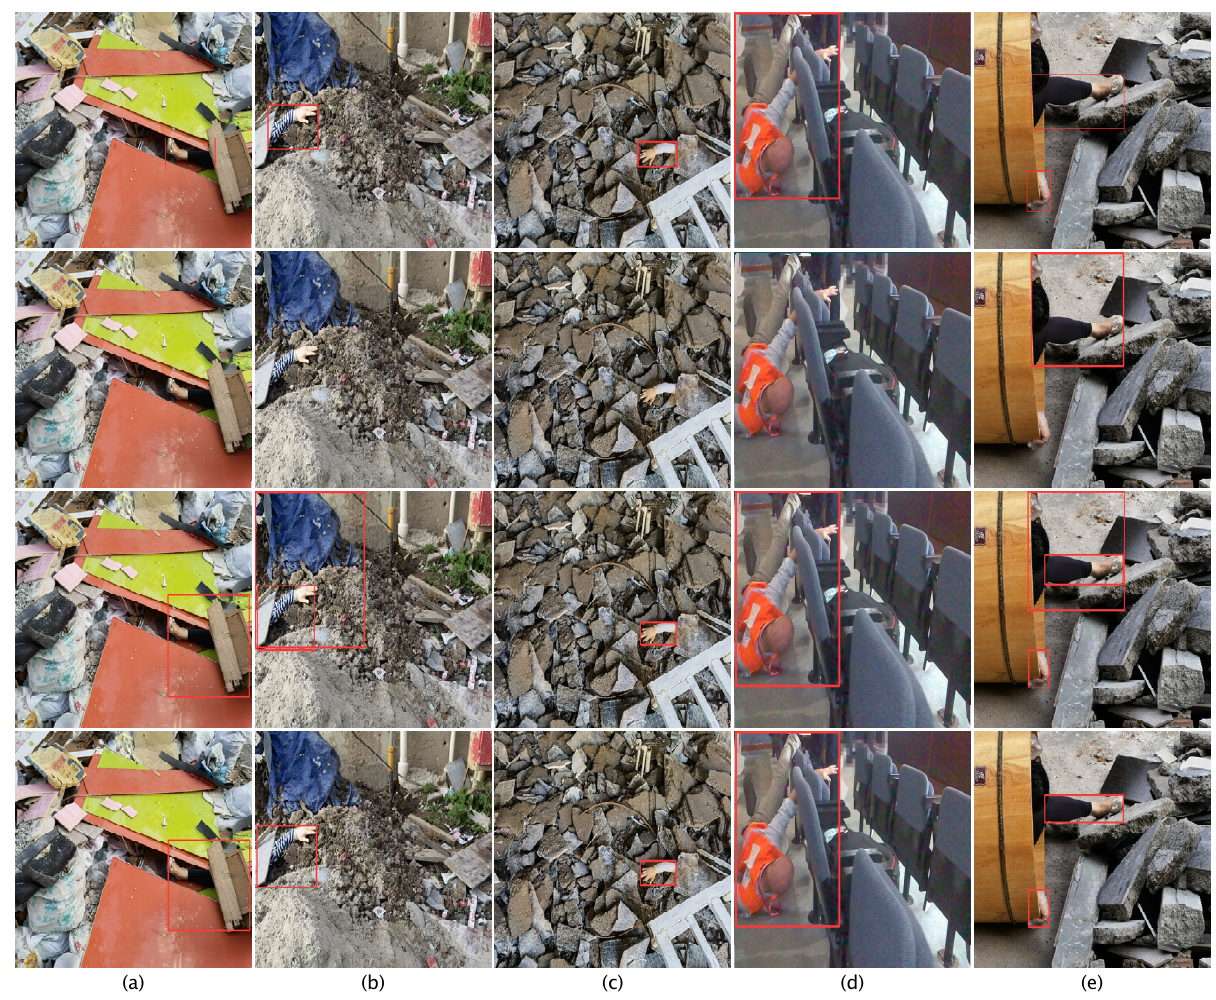
Figure 5. Visualization of victim detection. The first row is the ground-truth, and the second row is the default COCO pre-trained YOLOv5l model. The third row and the fourth row are the models fine-tuned on our composite images and harmonious images,